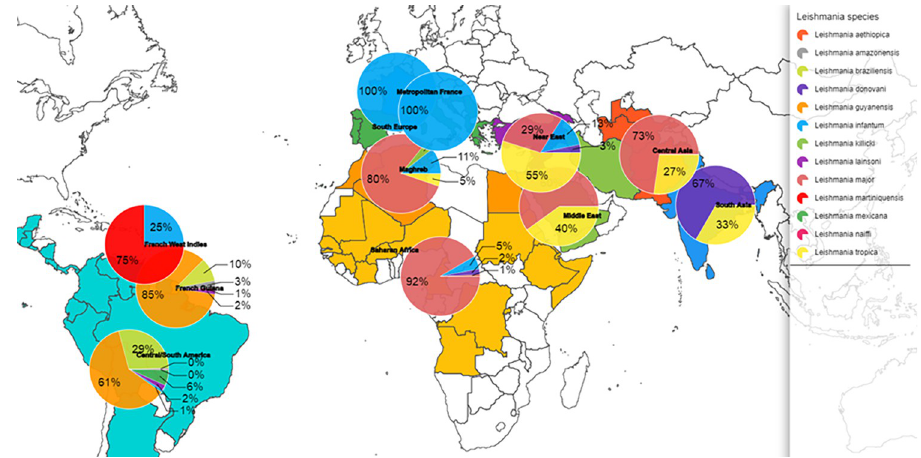
Fig 4. Distribution of Leishmania species according to the place of transmission from 1998 to 2020). (n = 3393, for 2986 other cases species was missing) Maps were designed with the Articque software (https://www.articque.com).